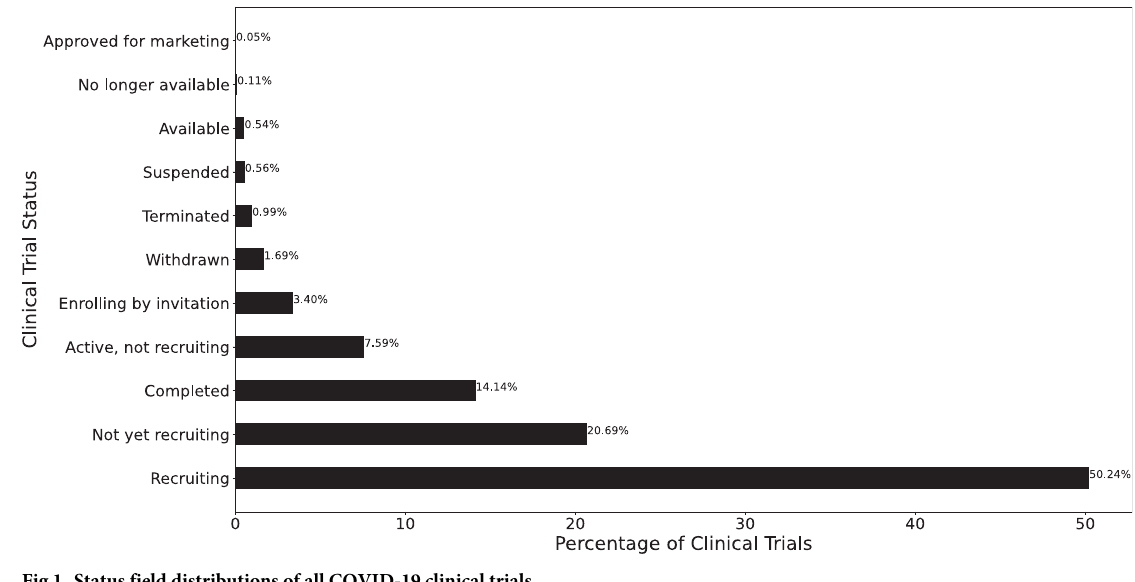
Fig 1. Status field distributions of all COVID-19 clinical